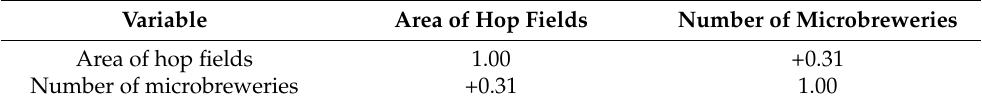
Table 2. Correlation matrix of residual components of